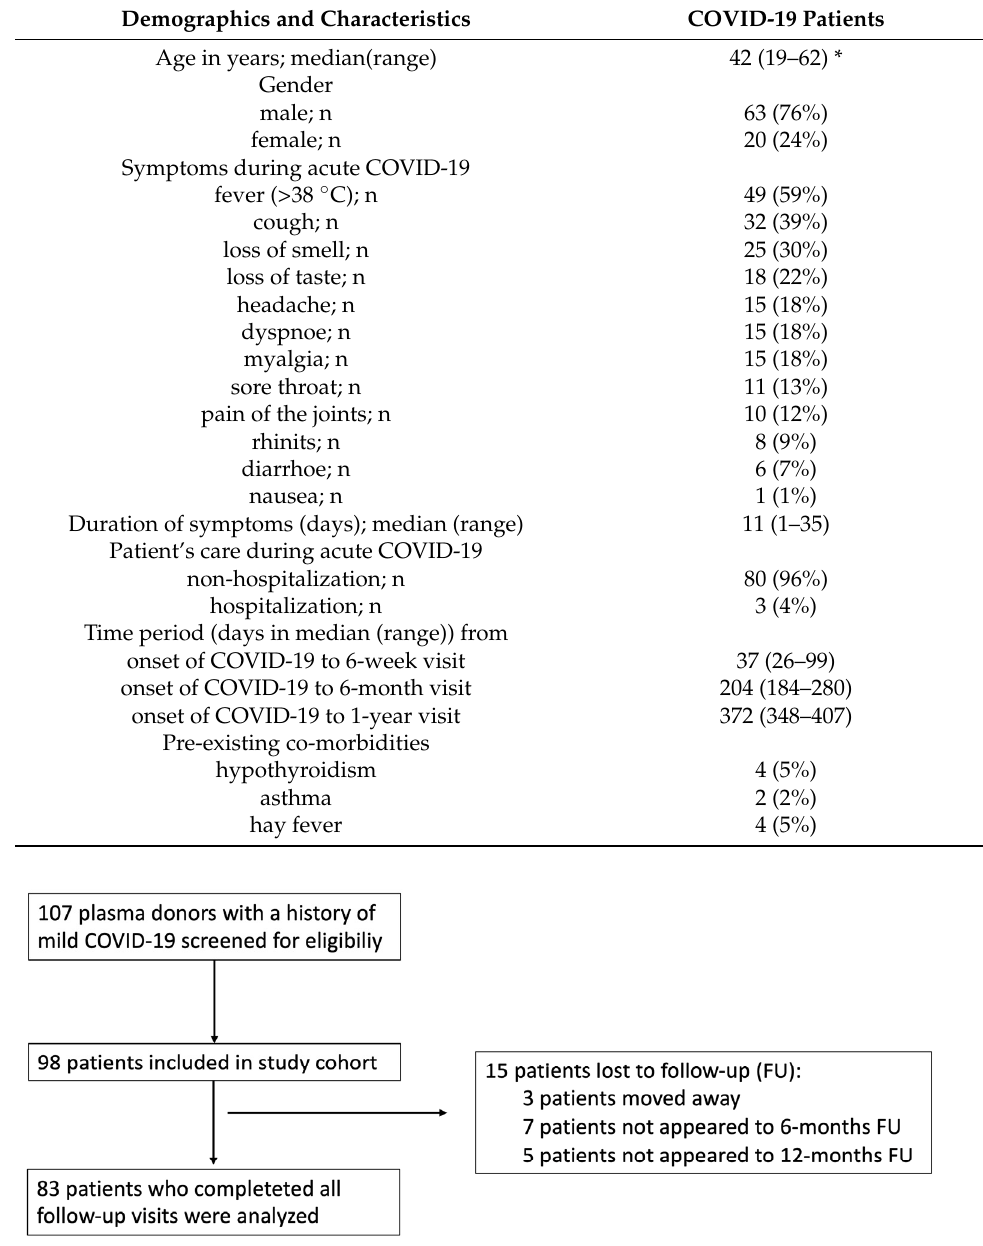
Table 1. Demographics and characteristics of 83 evaluable patients during acute COVID-19. * Homo- geneous distribution across the years.